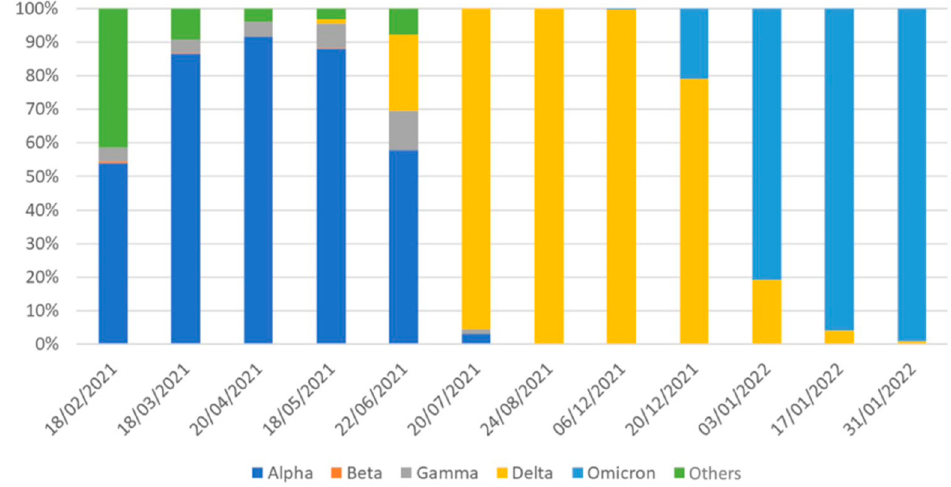
Figure 3. Prevalence of SARS-CoV-2 VOCs. This figure was created elaborating raw data from ISS [99].